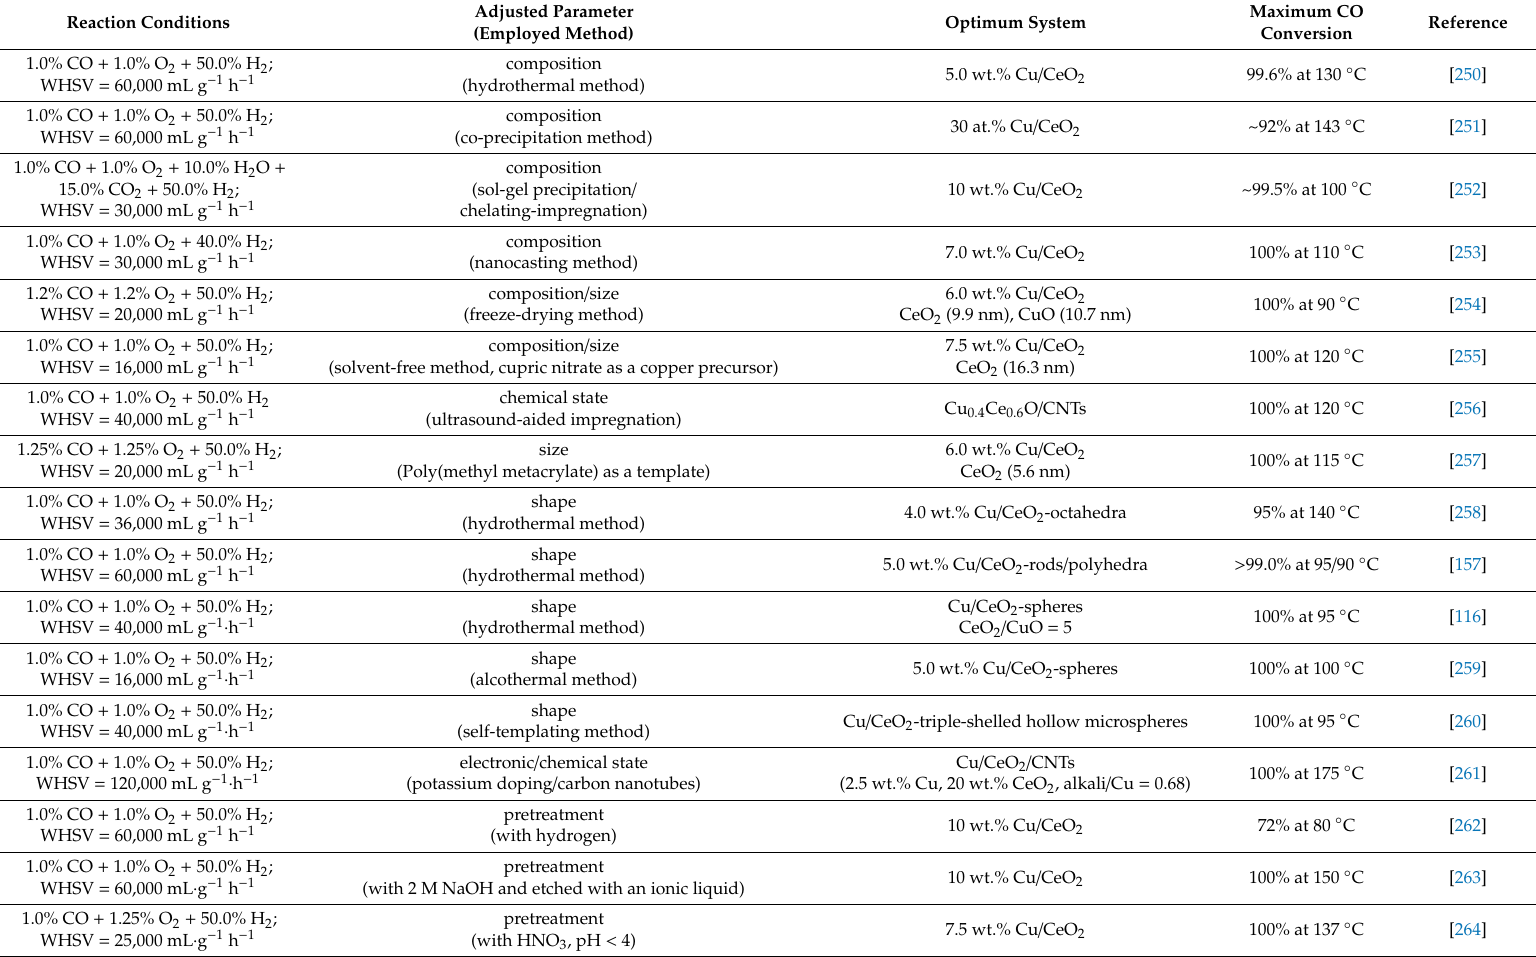
Table 3. Indicative studies towards adjusting the CO preferential oxidation performance of CuO x / CeO 2 oxides. Reaction